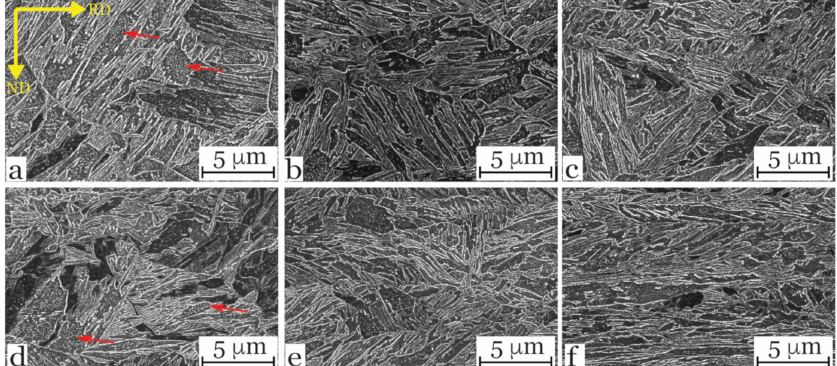
Figure 9. Typical microstructures of investigated steels recorded by FESEM; upper row: FRT 920 ◦ C,